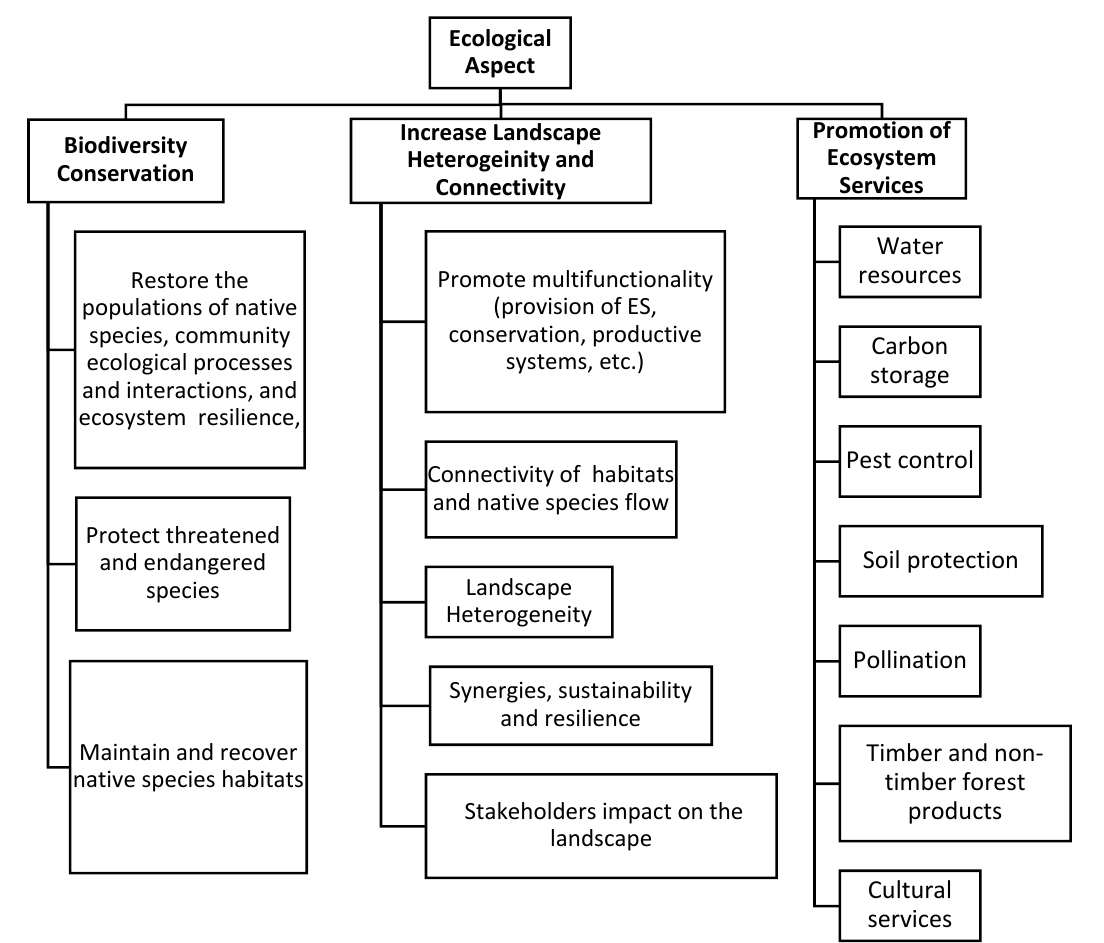
Figure 4. Ecological principles (top boxes) and criteria (lower, branched boxes) of FLR based on the review of 137 sources.